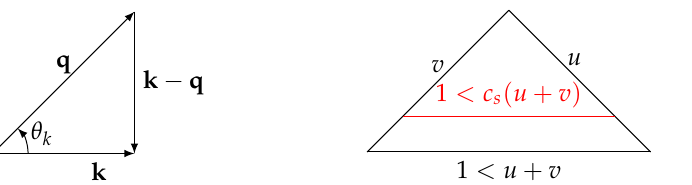
Figure 2. On the left, relation between the three vectors involved in the integrals of induced GWs for the Gaussian part. On the right, illustration of the triangle inequality. We see that when 1 < c s ( u + v ) and c s < 1 we are below the triangle inequality and the resonance is allowed by momentum